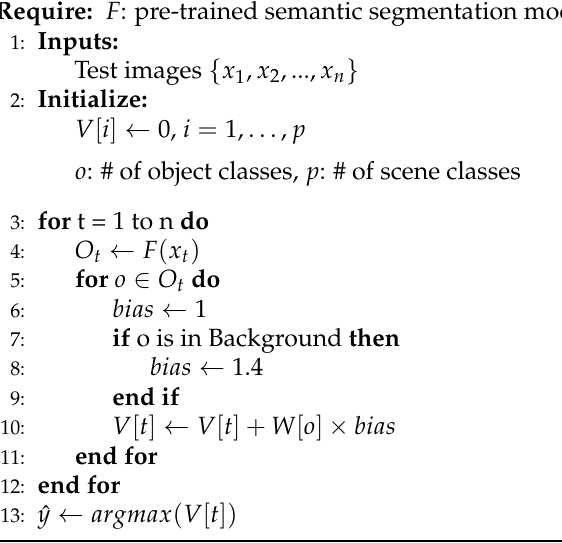
Algorithm 2 Inference